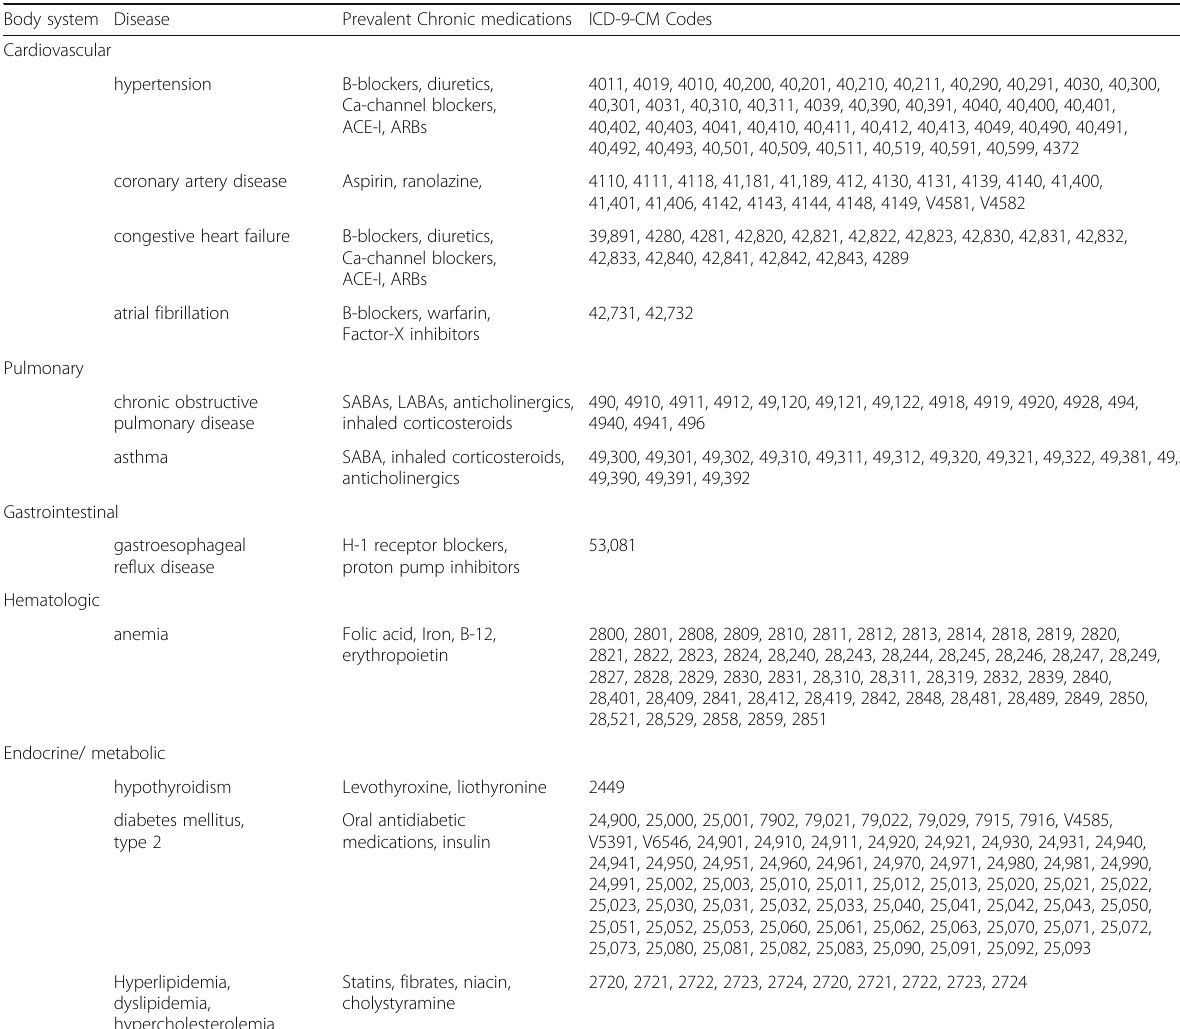
Table 4 Baseline comorbidities and associated ICD-9-CM codes Body system Disease Prevalent Chronic medications ICD-9-CM